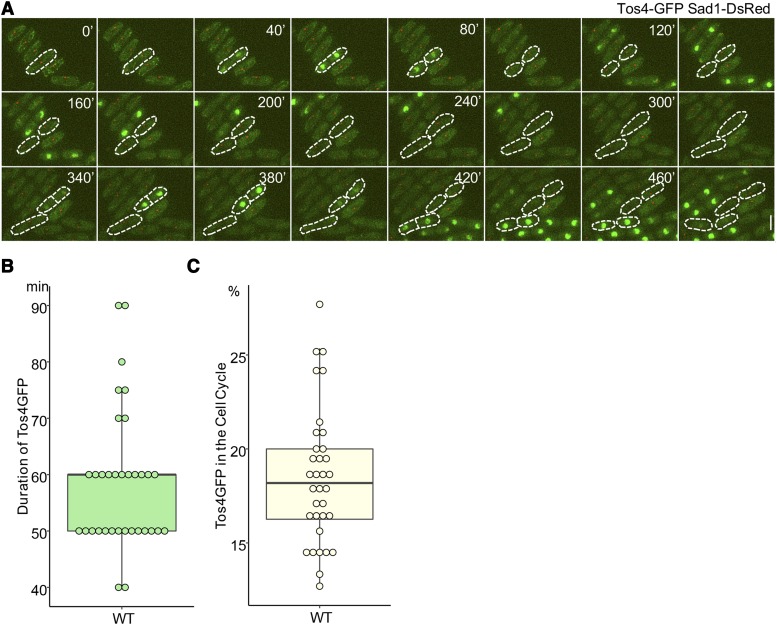
Tos4-GFP is present in nuclei of dividing cells. (A) Live cell imaging of WT cells containing Tos4-GFP and Sad1-DsRed was followed at 25°C for 8 hr. Nuclear Tos4-GFP signal is observed after duplication of SPBs and it disappears from the nucleus before cells enter the next round of mitosis. Scale bar, 5 µm. (B) Duration of the presence of nuclear Tos4-GFP. The presence of nuclear Tos4-GFP was determined by measuring the nuclear Tos4-GFP signals using the ImageJ software (Schindelin et al. 2012). Nuclear Tos4-GFP signals was counted as a positive when nuclear Tos4-GFP signal is greater than 50 (scale 0-255) after the background subtraction using ImageJ. (C) Ratio of nuclear Tos4-GFP duration vs. the cell cycle duration is presented. Duration of the cell cycle was determined by measurement of the timing between the first and second separation of SPBs. Sad1-DsRed was used to follow the separation of SPBs.